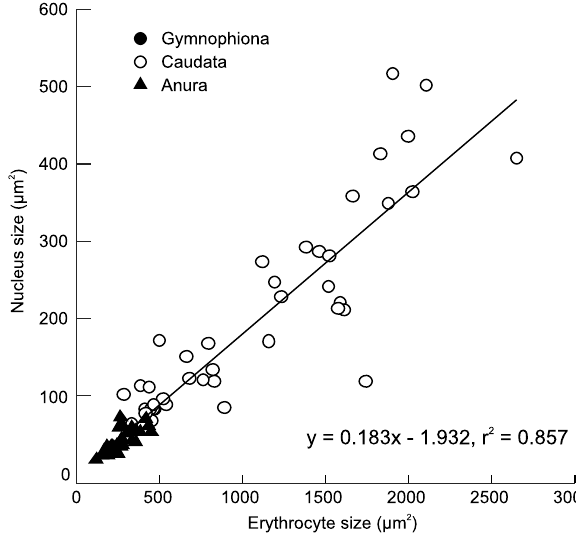
Figure 5 Ordinary least squares (OLS) regression of nucleus size on erythrocyte size in amphibians. Regression equation and coef- ficient are given in the